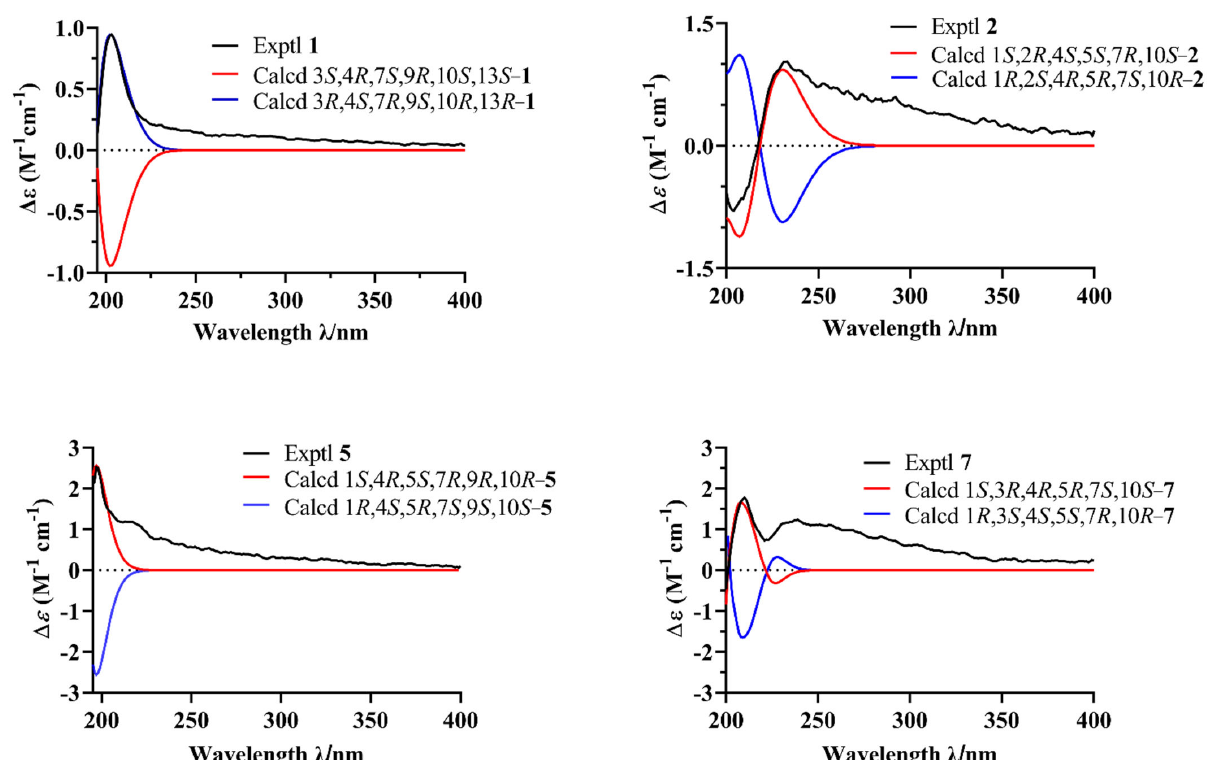
Figure 4. Experimental and calculated ECD spectrum of compounds 1 , 2 , 5 , and 7 . Biscogniauxiaol B ( 2 ) was obtained as a colorless solid with the molecular formula C 15 H 28 O 3 determined by the HRESIMS (Figure S11-S12), and a corresponding two degrees of unsaturation. The 1 H NMR data (Table 1) showed signals of three methyls at δ H 0.82 (3H, d, J = 7.2 Hz, H-14), δ H 0.88 (3H, d, J = 7.0 Hz, H-15), and δ H 1.29 (3H, s, H-11). The 13